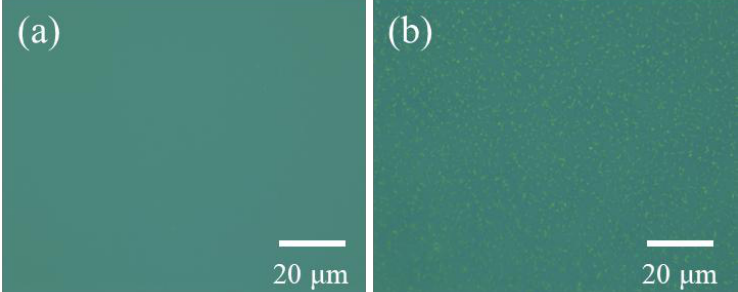
Figure 2. Optical microscope images of spin-coated nanostructures with 1:1 mass ratios of PDI 8 -CN 2 /PMMA at a total concentration of 5mg/mL on a Si/SiO 2 substrate ( a ) before and ( b ) after SVA.